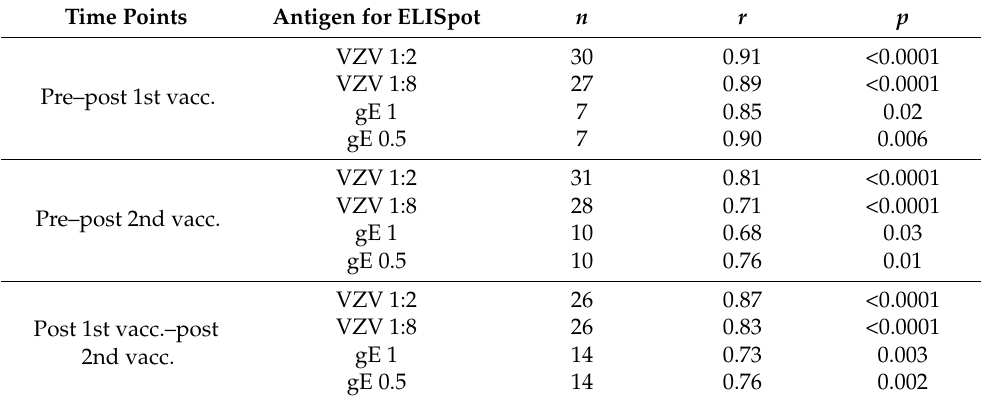
Table 5. Spearman correlation analysis of VZV-specific ELISpot responses prior to and post vaccina- tion in patients after hematopoietic stem cell